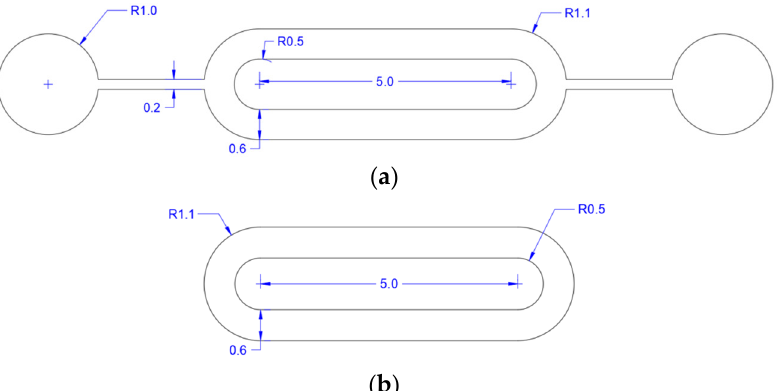
Figure 2. Schematic of PDMS channel and glass groove: ( a ) Dimensions of the PDMS channel; ( b ) Dimensions of the glass groove.